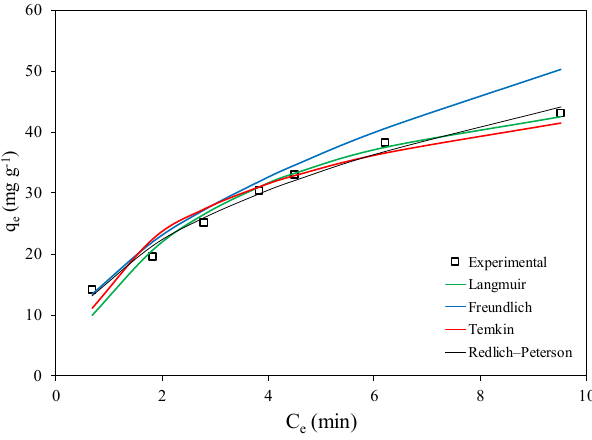
Fig. 12: Isotherms obtained using the non-linear method for the Fig. 12. Isotherms obtained using the non-linear method for the adsorption of MB on SD/MgO. adsorption of MB on